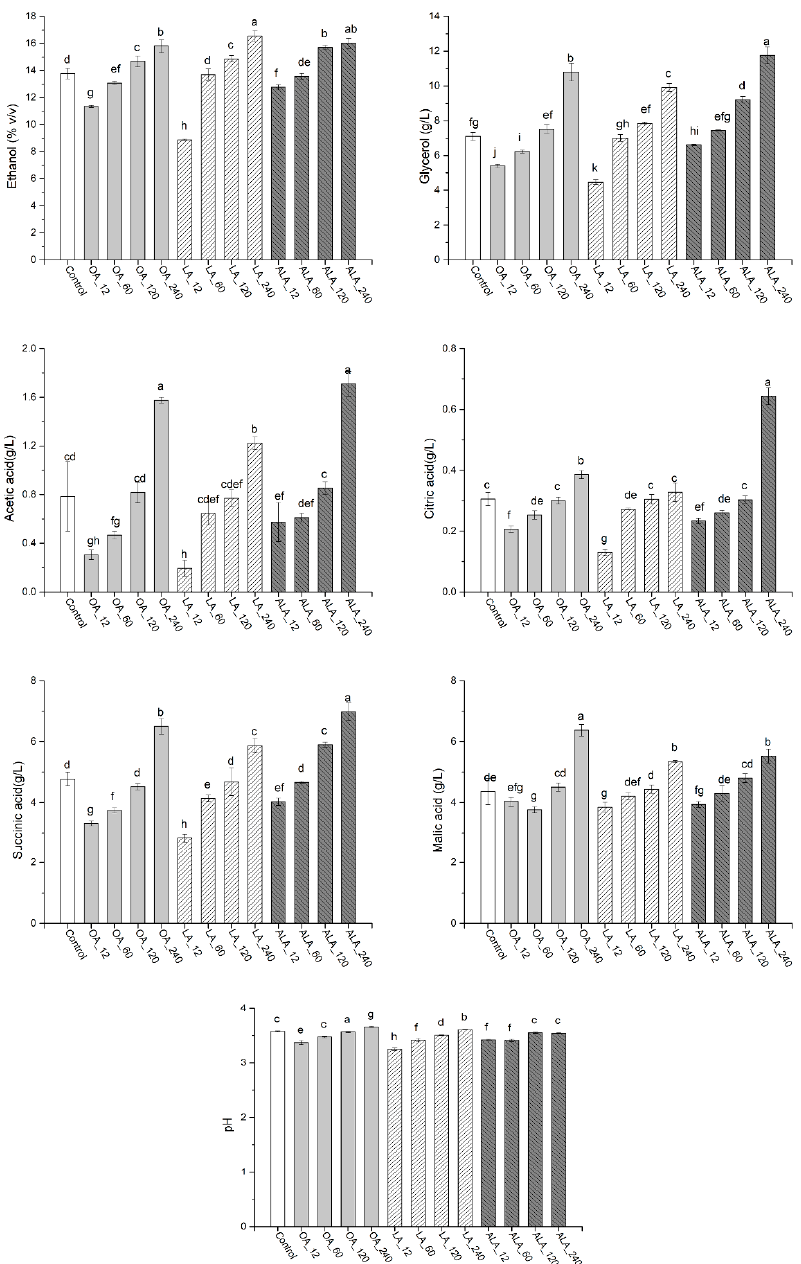
Figure 1. Effect of different treatments on the composition of wines. Values of the same compound marked with the same lowercase letters indicates no significant difference ( p < 0.05, Duncan’s test).